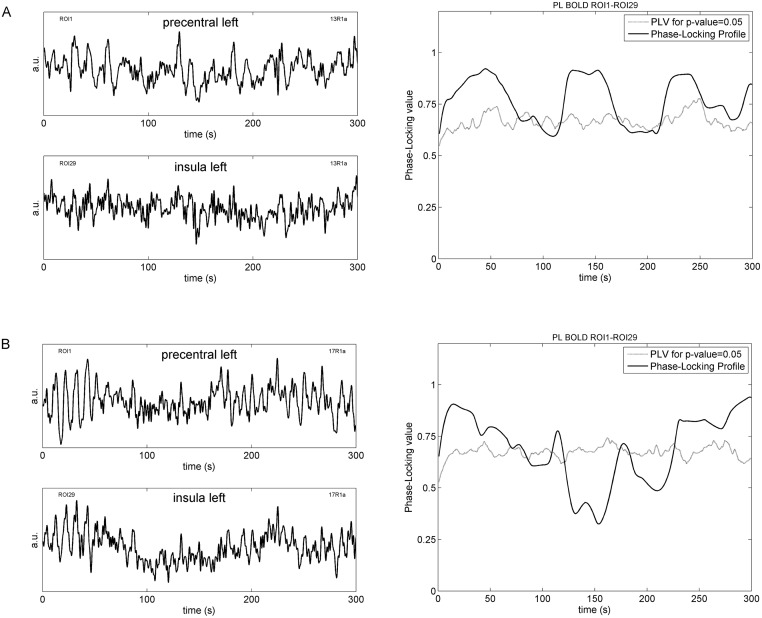
Left side: Examples of BOLD time series (PCG and insula) from two characteristic individuals, one with vascular BOLD (nTD) oscillations (participant 13R1a; A) and one with neural BOLD (pTD) oscillations (participant 17R1a; B). Right side: corresponding PL profiles (i.e., plots of PL across time) with threshold (PLV for p = .05) for an individual with nTD (delay: -0.42 s, %sigbins: 84%) and an individual with pTD (delay: 0.05 s, %sigbins: 60%).